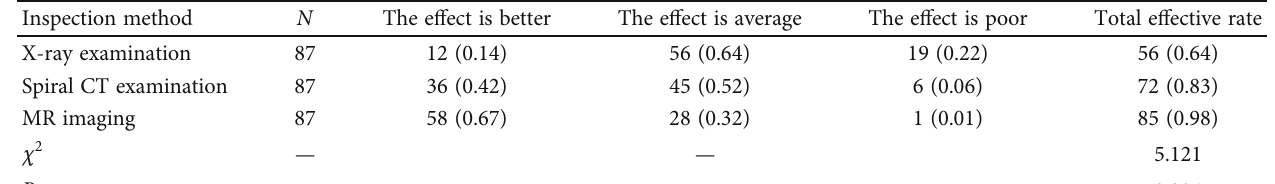
Table 5: Comparison of three inspection